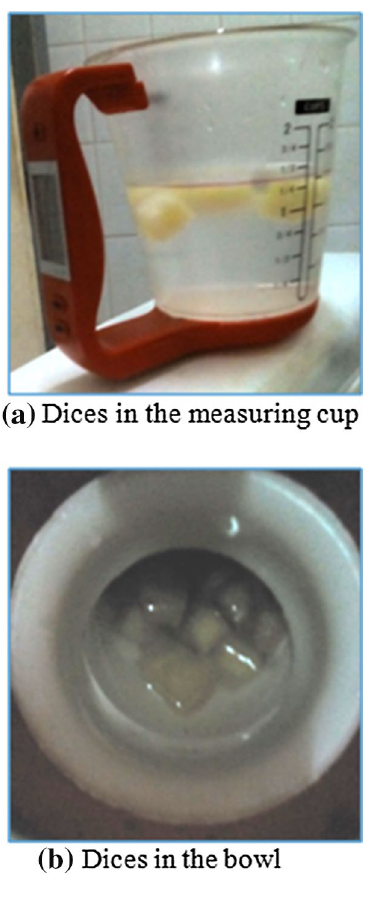
Fig. 10 Melon dices used in the experiment